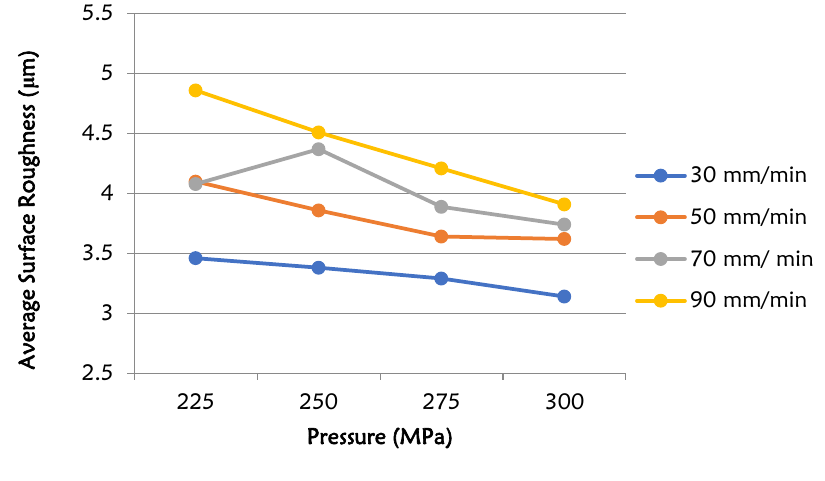
Figure 8: A plot of influence of jet pressure on the average surface roughness